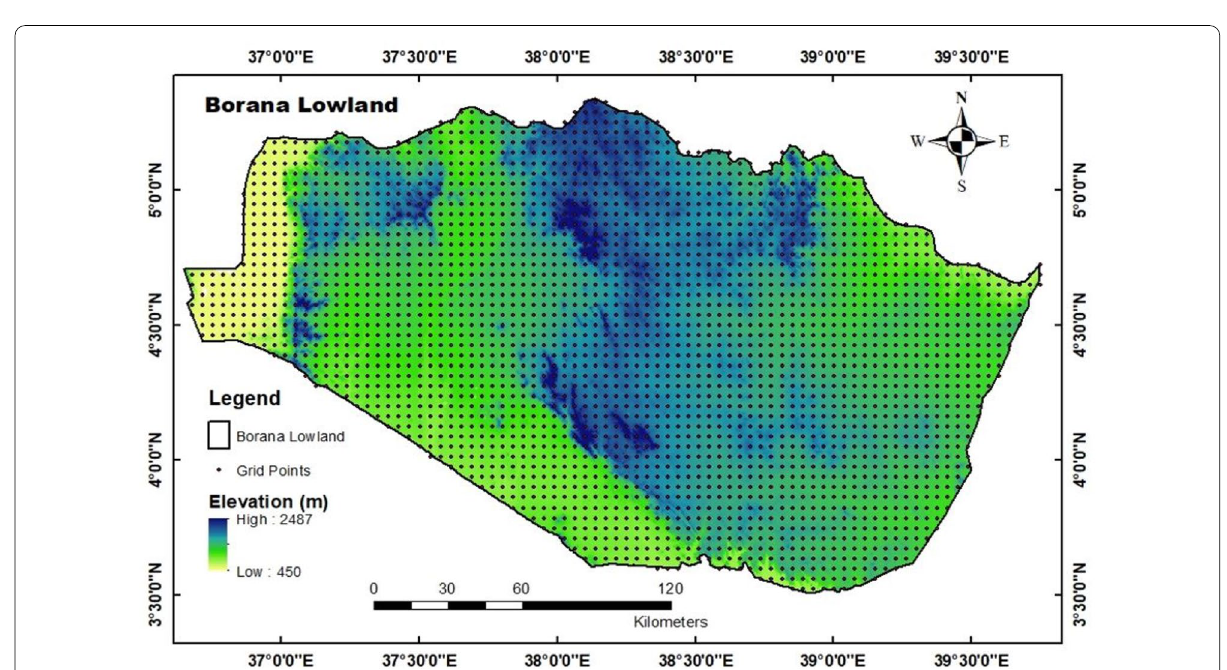
Fig. 2 Data grid points in the Borana